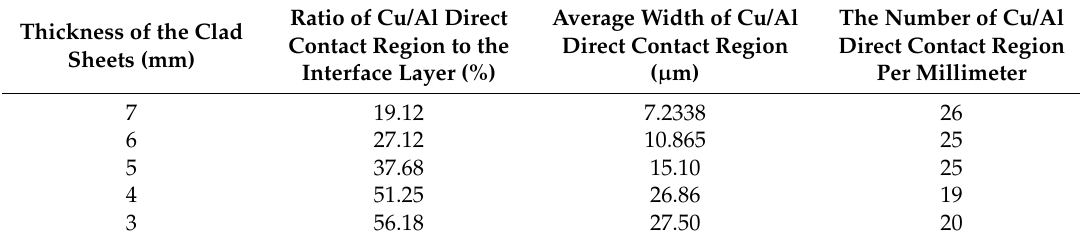
Table 3. Ratio of Cu/Al direct contact region to the interface layer, average width of Cu/Al direct contact region, and the number of Cu/Al direct contact region per millimeter with different thicknesses of the clad sheets.